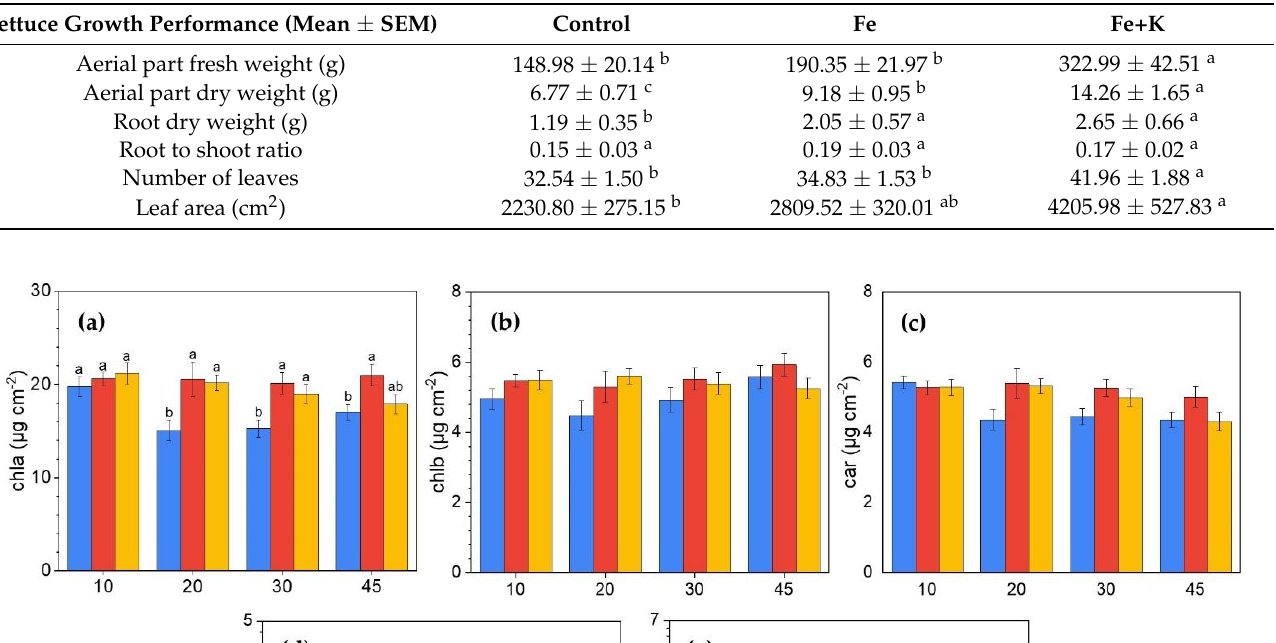
Table 4. Growth parameters of lettuce measured at the final harvest (Mean ± SEM, n = 24). Different superscripts in a row denote statistically significant differences among treatments ( p < 0.05).